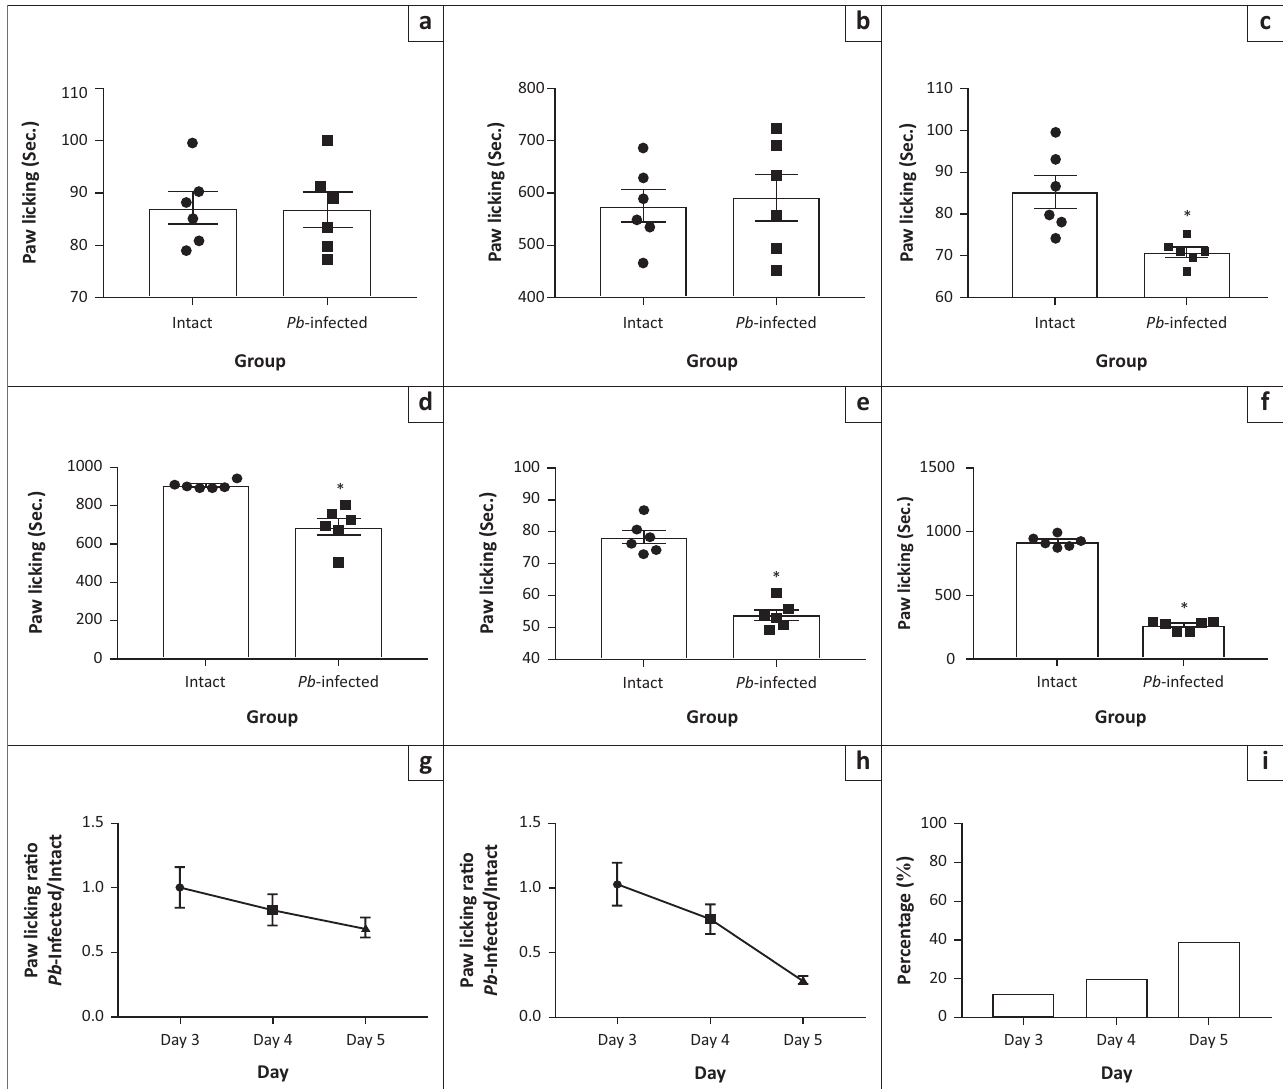
FIGURE 3: Pb -induced analgesia in mice. (a) and (b) Time spent on paw licking during the early (0–5 min) and late (20–50 min) phase of formalin test on Day 3 post- Pb inoculation (early phase and late phase), respectively. (c) and (d) Time spent on paw licking during the early (0–5 min) and late (20–50 min) phase of formalin test on Day 4 post- Pb inoculation (early phase and late phase), respectively. (e) and (f) Time spent on paw licking during the early (0–5 min) and late (20–50 min) phase of formalin test on Day 5 post- Pb inoculation (early phase and late phase), respectively. (g) and (h) Successive trend of pain sensitivity during the neurogenic and inflammatory pain (early phase pain perception and late phase pain perception), respectively. (i) Percentage parasitaemia level on Days 3, 4 and